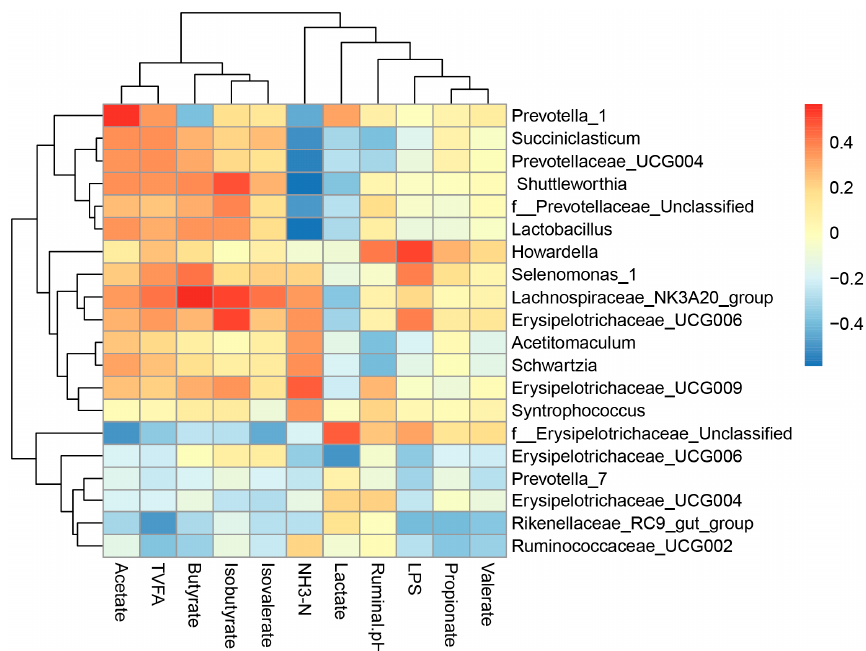
Figure 4. Coefficients of correlation between relative abundances of bacteria genera, and ruminal fermentation parameters.